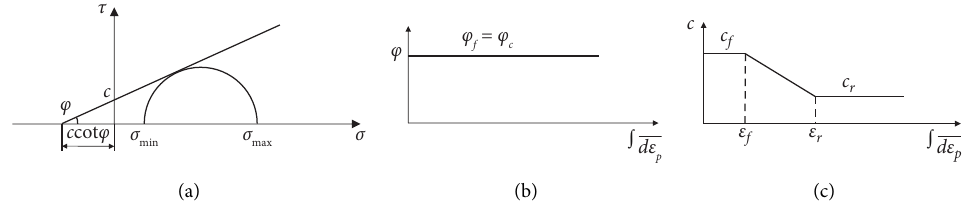
Figure 2: Te strain-softening Mohr–Coulomb model: (a) yield criterion; (b) variation of φ with the accumulated plastic strain; and (c) variation of c with the accumulated plastic